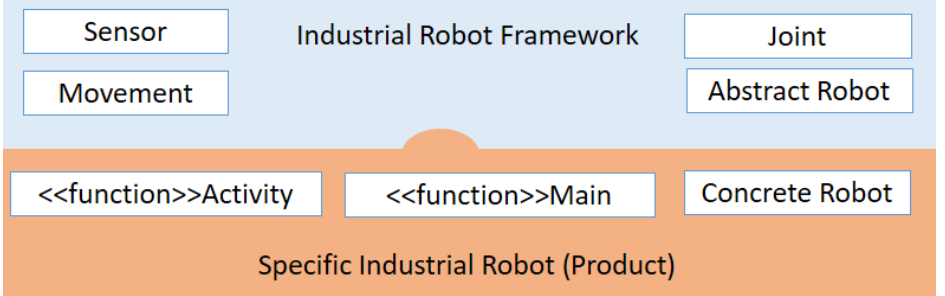
Figure 2. IRArduino-SPL